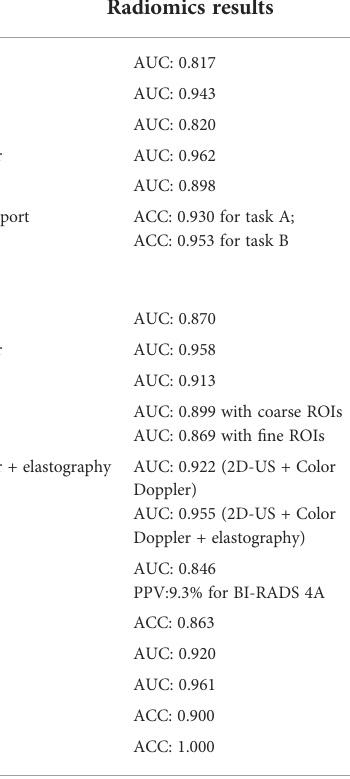
TABLE 1 Summary of ultrasound radiomics studies in breast diagnosis.